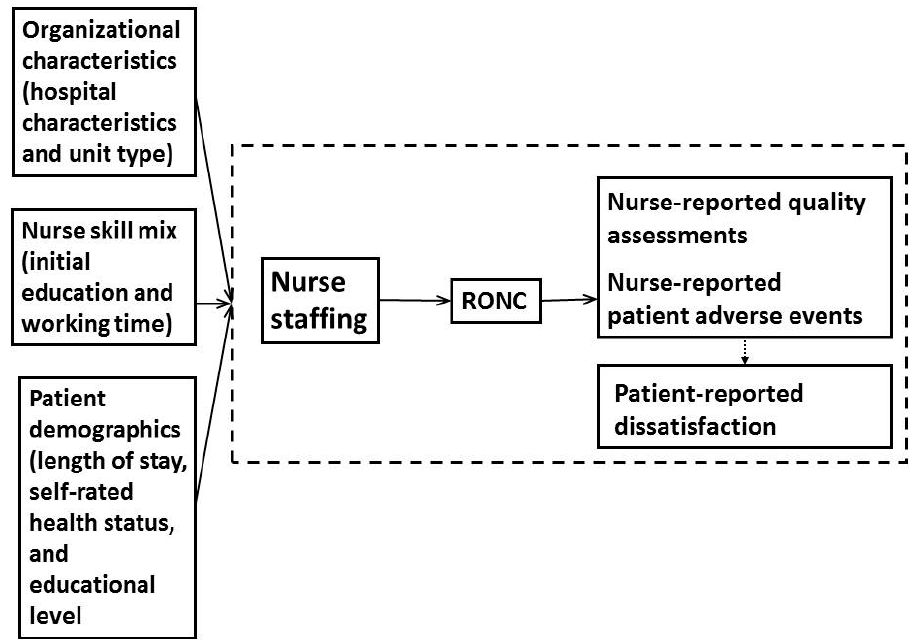
Figure 1. Hypothesized relationships among organizational characteristics, nurse skill mix, patient demographics, nurse sta ffi ng, rationing of nursing care (RONC), and patient outcomes.